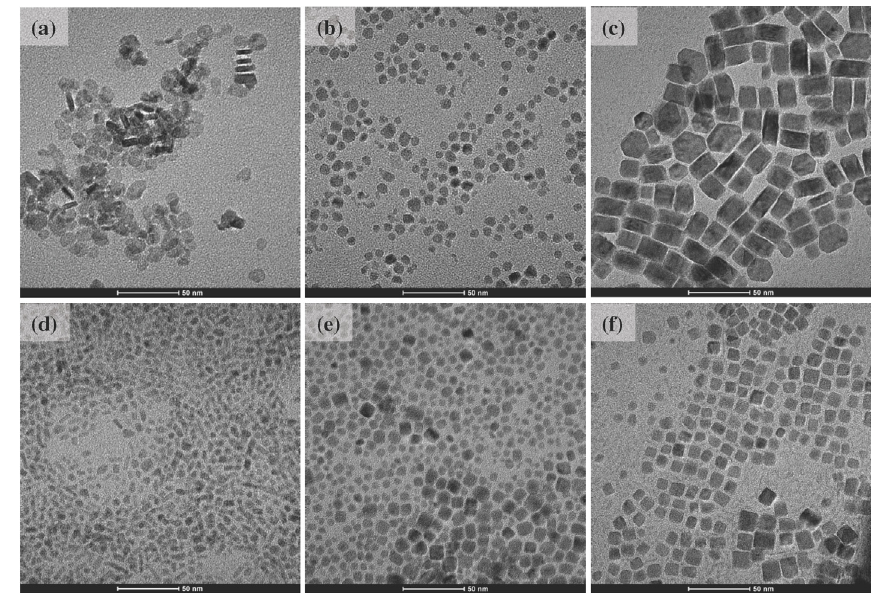
Figure 2. Comparative emission spectra of 0.5%Tm, 20%Yb codoped UCNCs in host (12.6 ± 2.5 nm) (intensity shown scaled ×1000) ( Green ); ( a2 ) (Na)LaF lattices. ( a1 ) LaF 3 (7.7 ± 1.9 nm) ( Blue ); ( a3 ) (Na)LaF @(Na)LaF (22.7 ± 4.5 nm) ( Violet ); ( b1 ) BaLaF 3 3